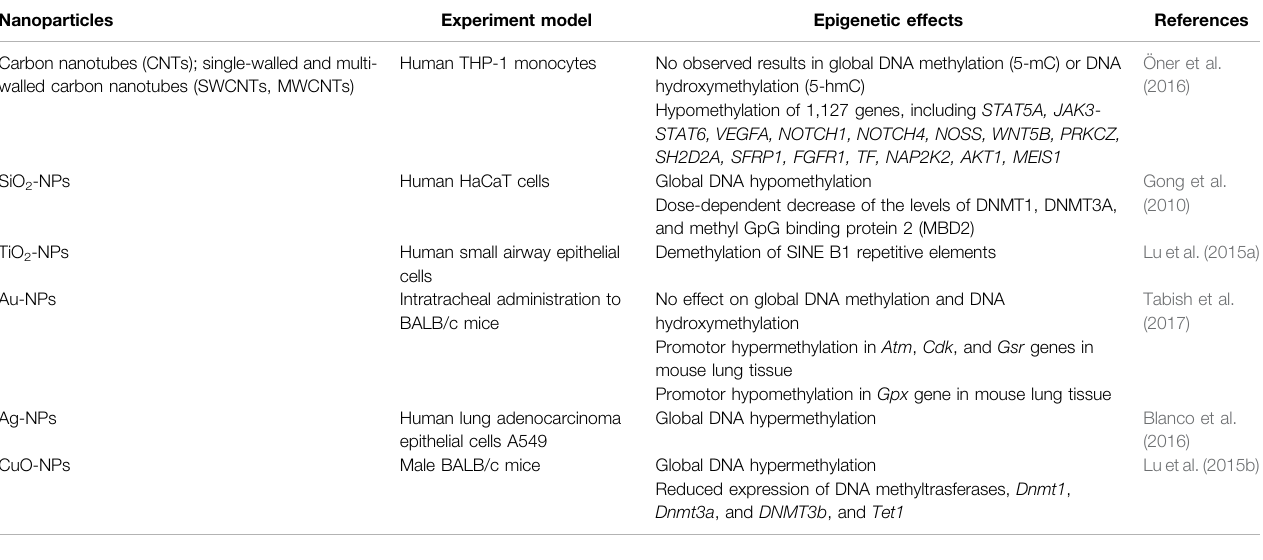
TABLE 3 | In vitro and in vivo studies on impact of nanoparticles on DNA methylation.